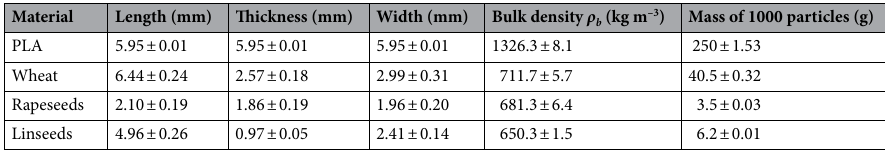
Table 1. Basic mechanical parameters of PLA particles and seeds used for experiments.